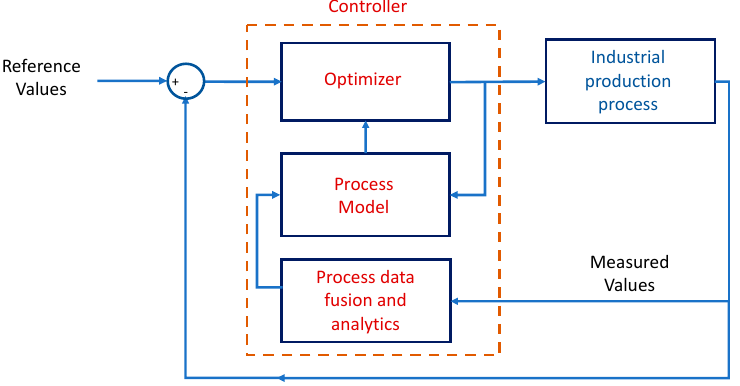
Figure 1. Model-based optimized controller.